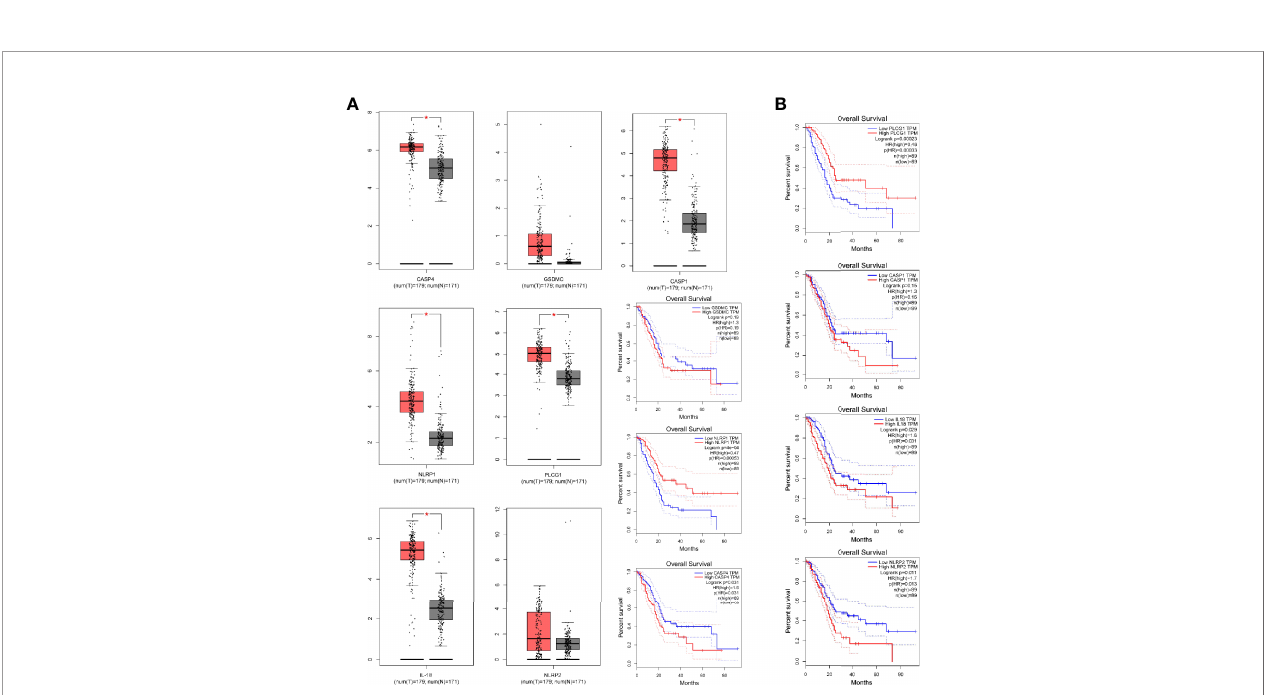
FIGURE 8 | Sensitivity to chemotherapeutic agents in the high - and low-risk groups. (A) RNAss between high- and low-risk groups. IC50 of (B) paclitaxel, (C) erlotinib and (D) rapamycin between high- and low-risk groups. (E) Comparison of the C-index of our model with other previously established models. (F) Sankey diagram showing the correlation among tumour classi fi cation, PP-score and risk signature.